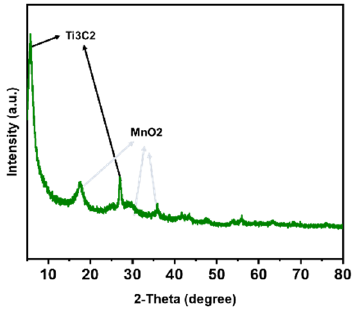
Figure 2. XRD patterns of MnO 2 /MXene composite films.